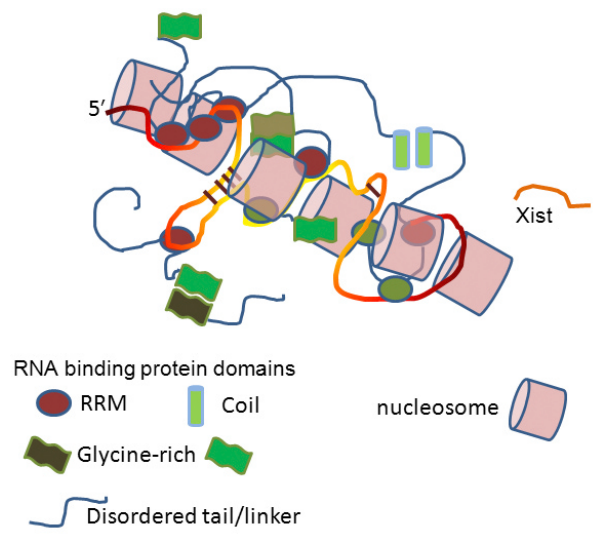
Figure 1. Xist wraps around nucleosomes in the X chromosome. Approximately 200 Xist molecules bind to an X chromosome, spread along it, and inhibit RNA polymerase II from transcribing the DNA. Xist is bound by many proteins at unknown sites and with unknown stoichiometry, which subsequently interact with each other through disordered regions or structured domains. RNA is shown as a yellow/orange strand and protein linkers as blue strands. RRM, RNA recognition motif.